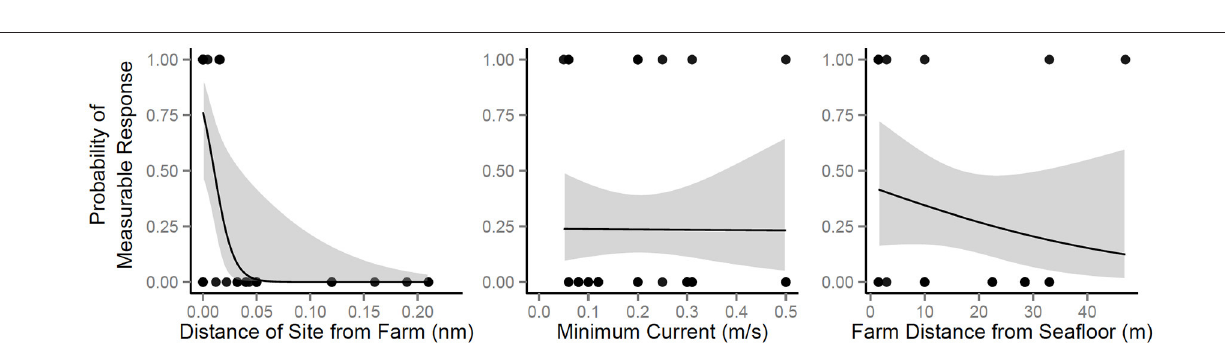
no impact (mean ± SD = 0.22 m/s ± 0.16). Similarly, the mean distance from the seafloor was also slightly closer (16.4 m ±